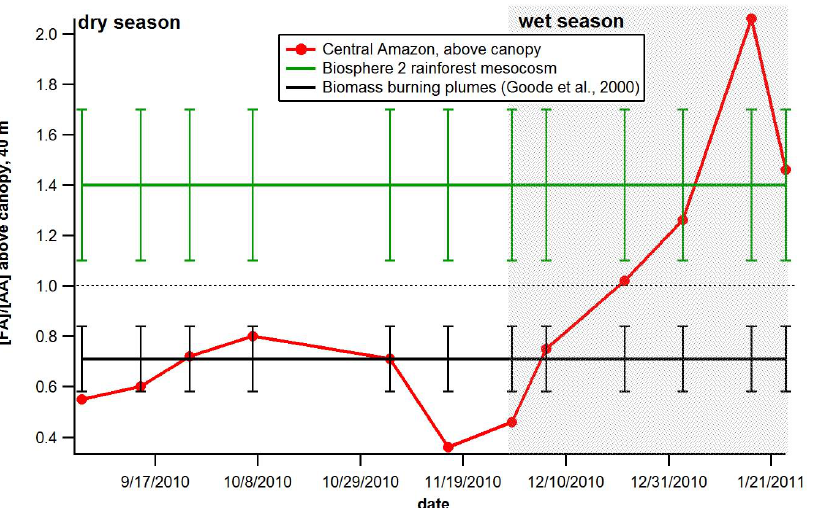
Fig. 5. Time series of FA/AA concentration ratios above the canopy in central Amazonia (40m) through the 2010 dry and 2011 wet seasons showing a potential switch between a biomass burning dominated source in the dry season to a vegetation dominated source in the wet season. For comparison, average FA/AA ratios observed in the Biosphere 2 tropical rainforest mesocosm measured in this study and from biomass burning plumes in Goode et al., 2000 are also shown (error bars represent one standard deviation).